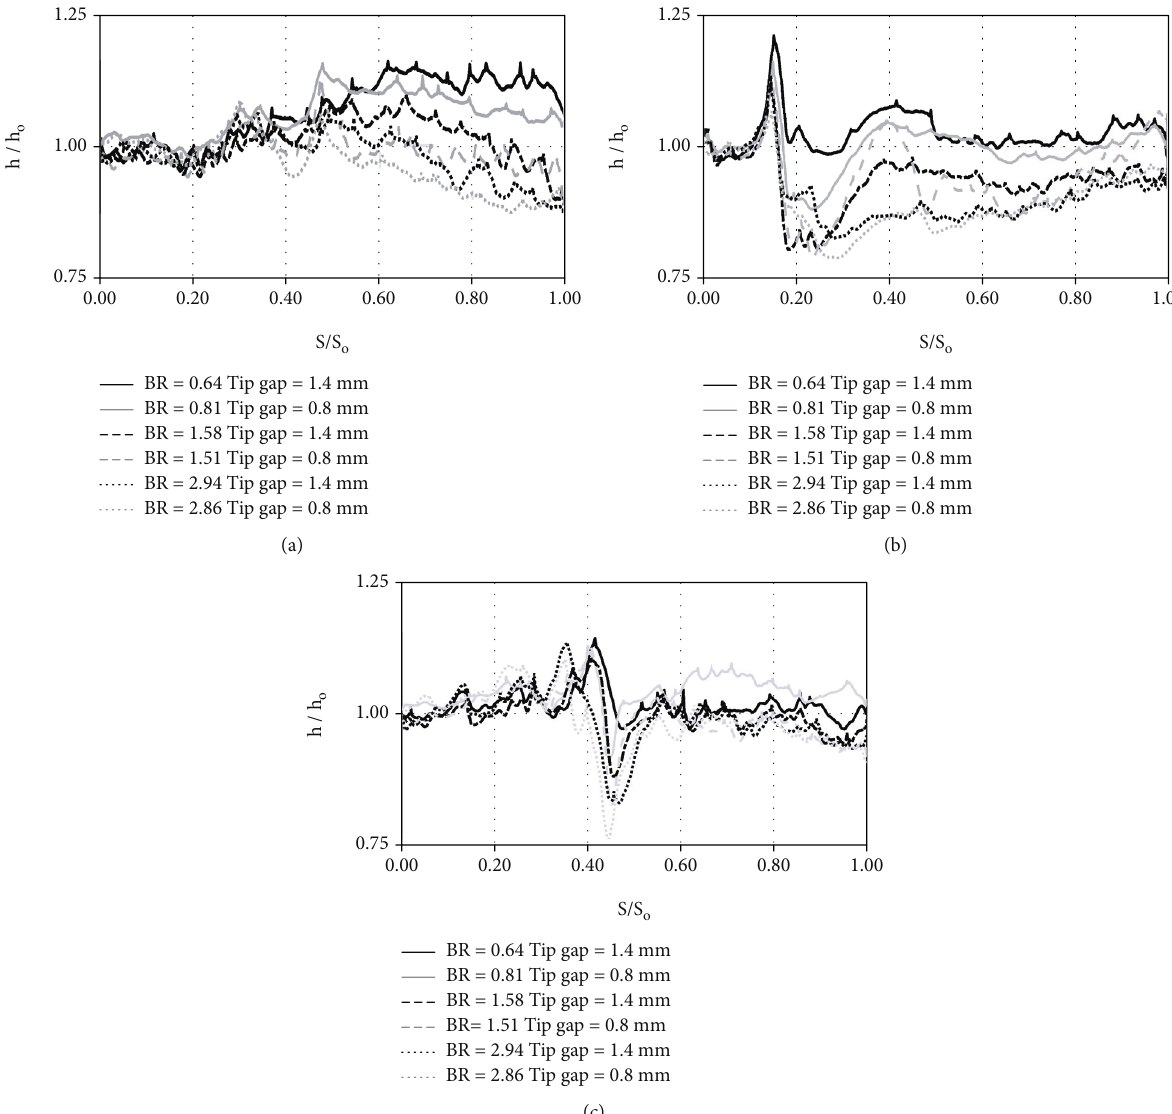
Figure 12: Line-averaged heat transfer coe ffi cient ratio along for A1 blade fi lm cooling for di ff erent blowing ratios and tip gaps. (a) Along the pressure side rim. (b) Along the squealer recess region. (c) Along the suction side